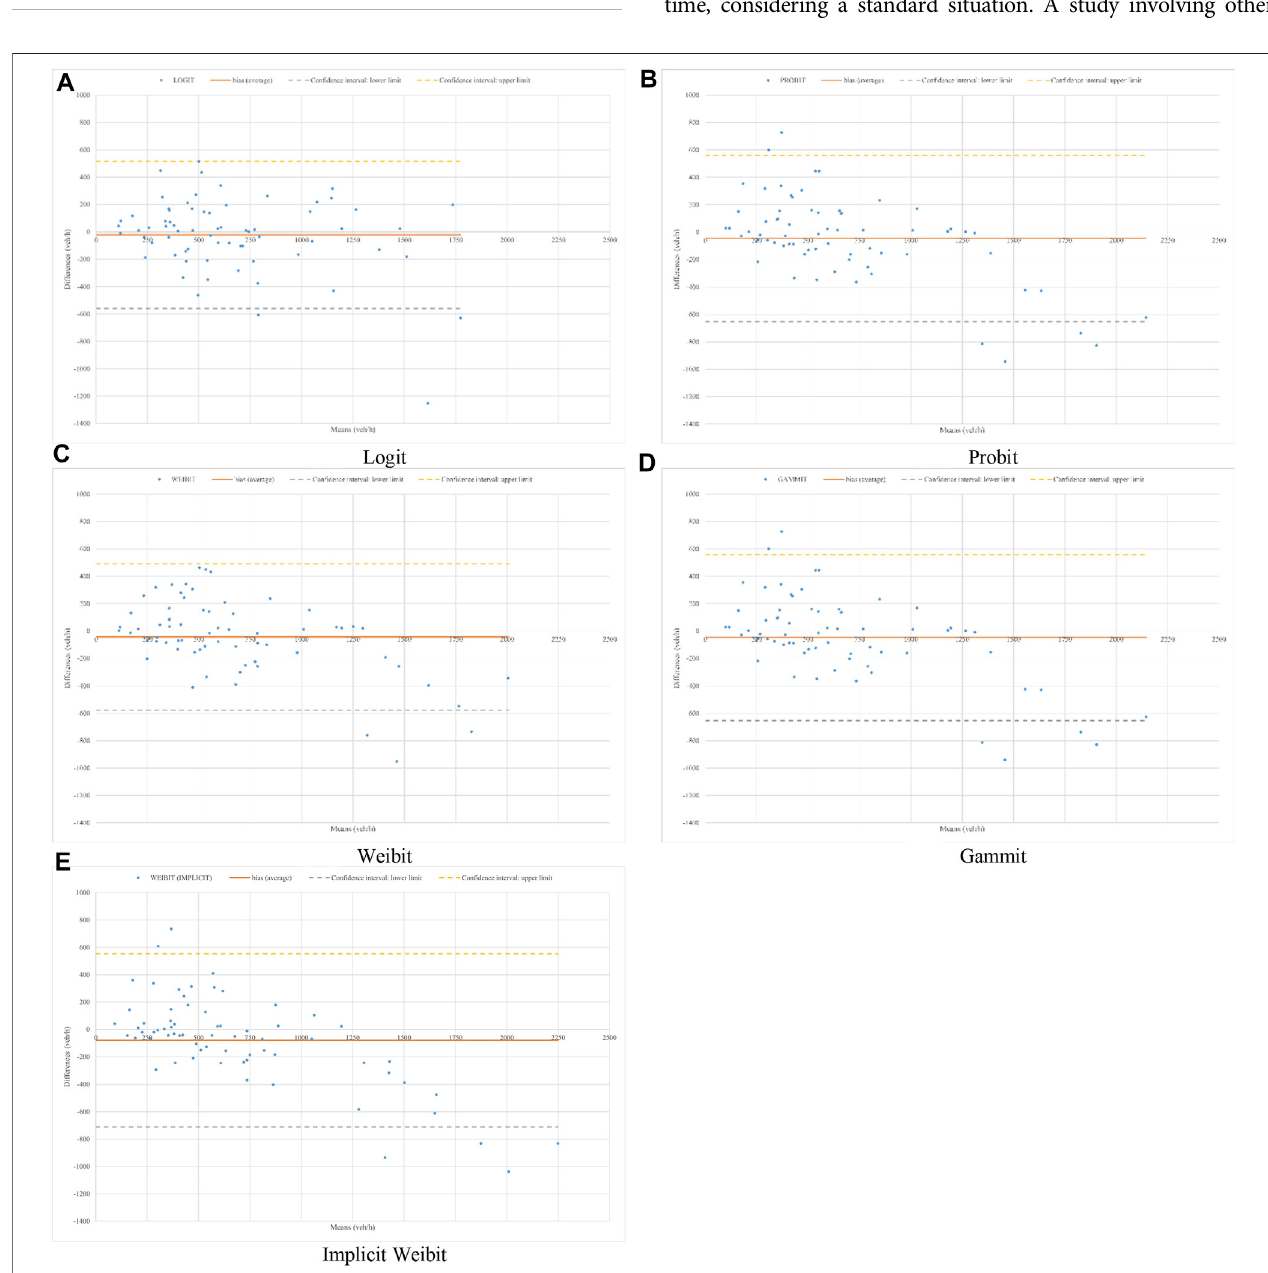
FIGURE 9 | Comparison of link fl ows: Bland – Altman plot.